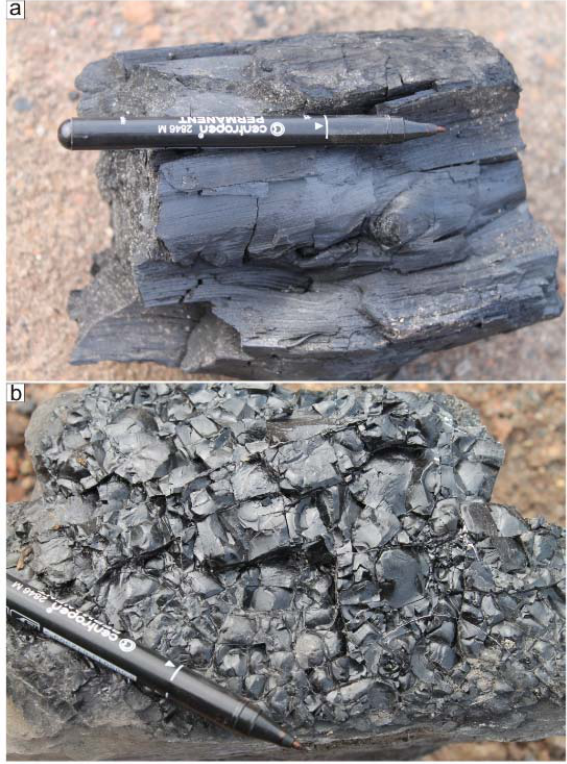
Figure 4. Products from pyrolysis activated zone: ( a ) activated charcoal; ( b ) heavy fractured coal with bright anthracite luster.